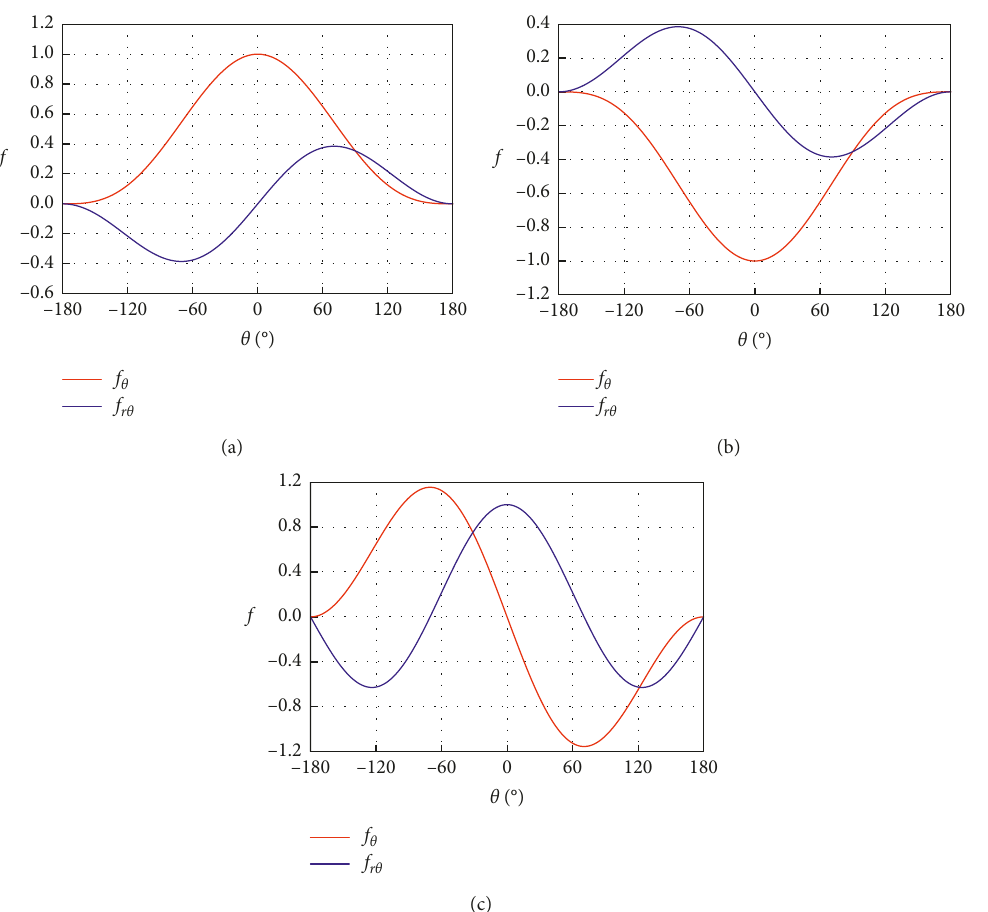
> 0; (b) mode-I crack without friction, σ N